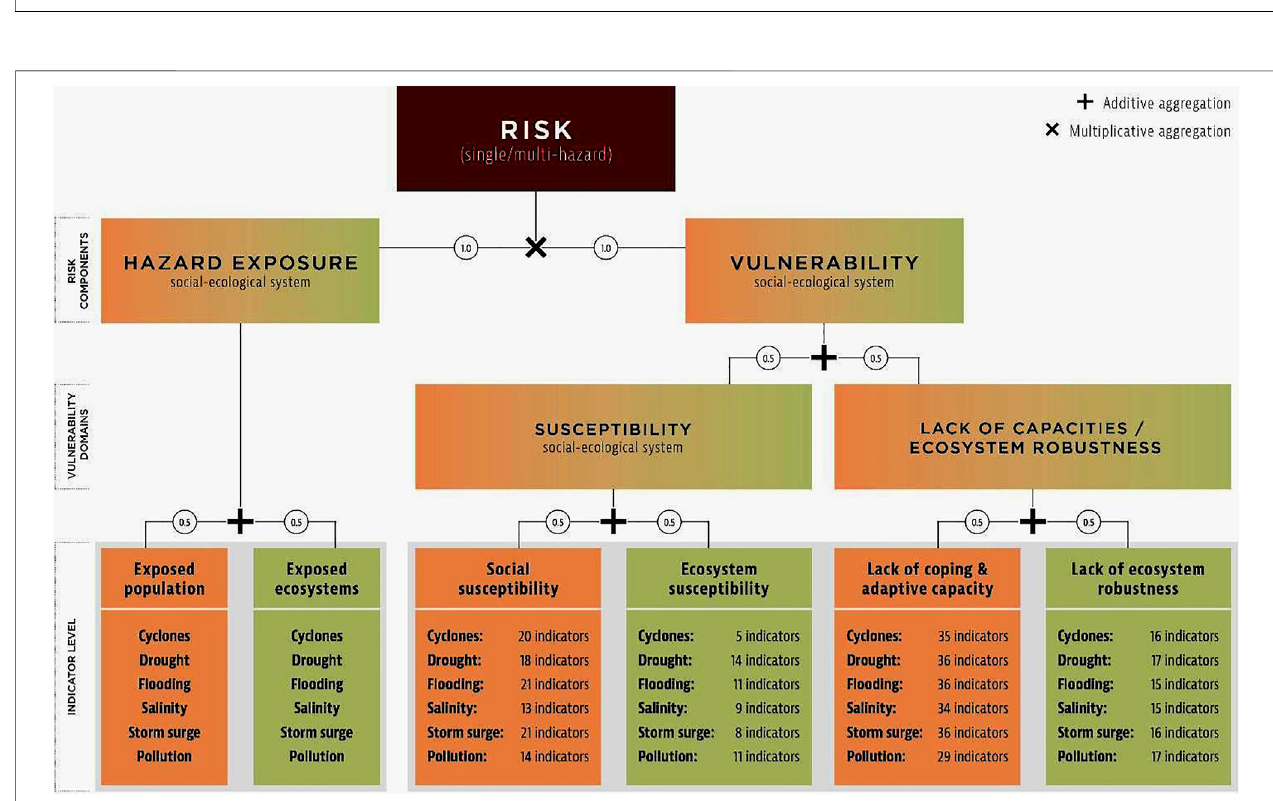
FIGURE 9 | The Global Risk Index: concept and structure. Credit: Hagenlocher et al. (2018).